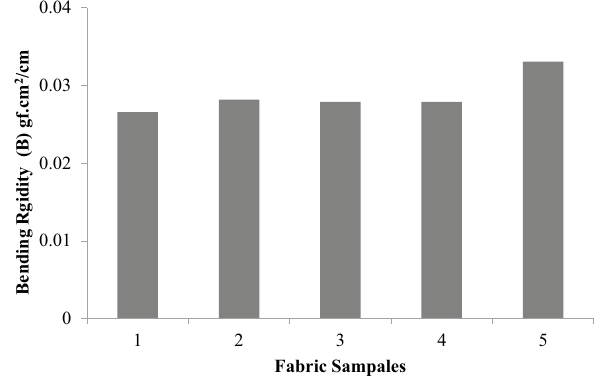
Figure 5. Bending rigidity (B) of samples.